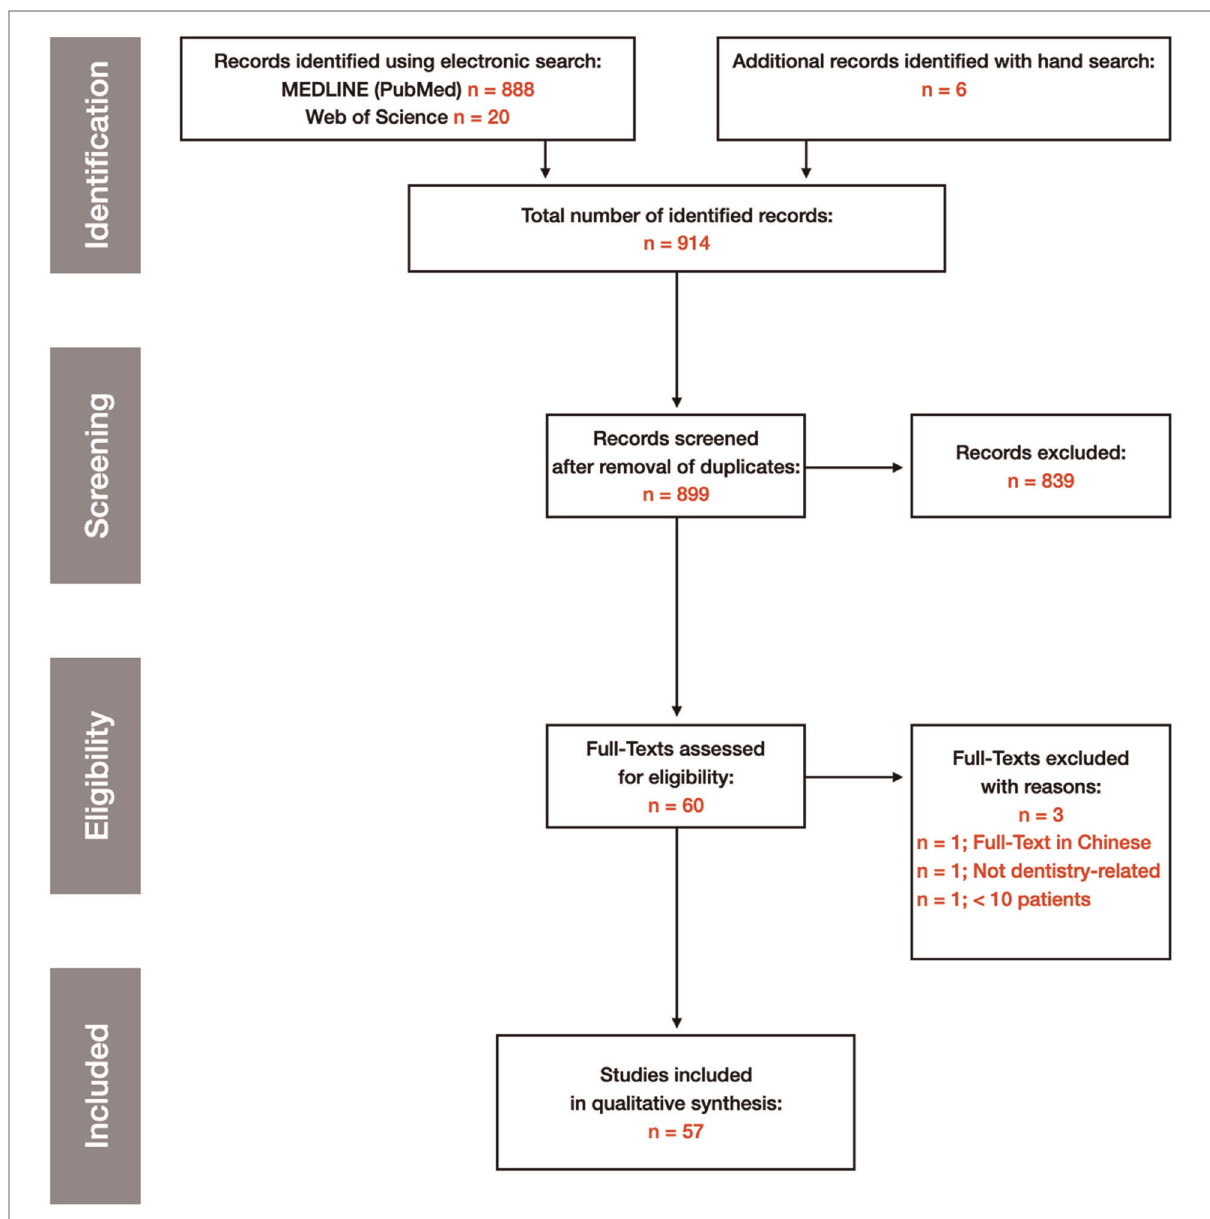
FIGURE 1 Search fl owchart from identi fi cation to included